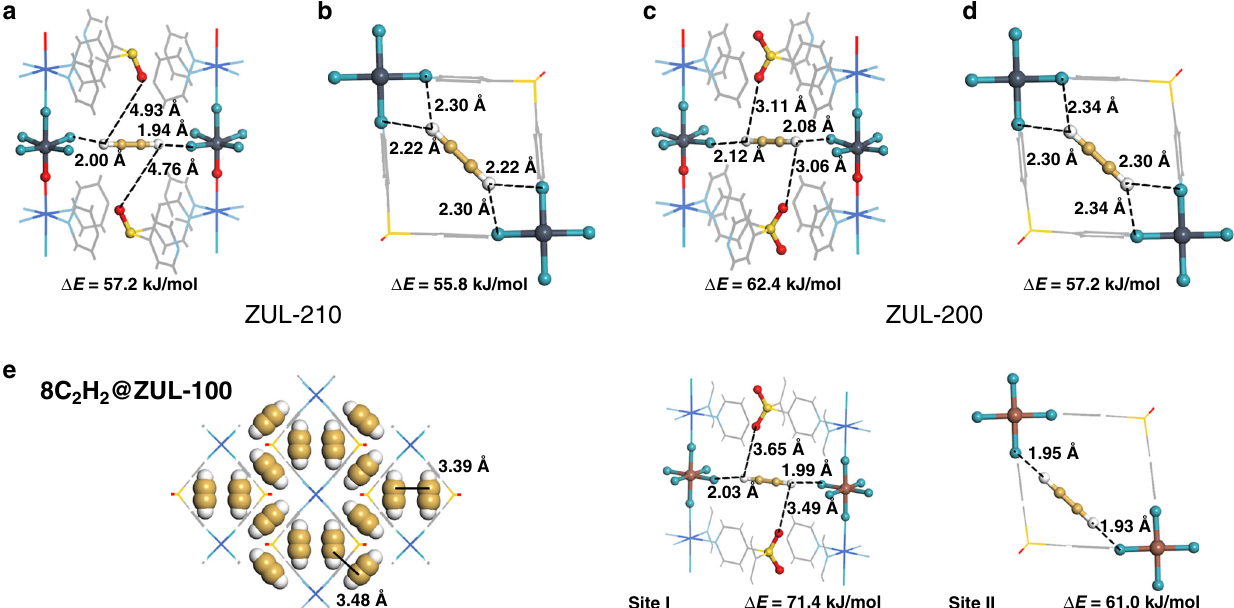
Fig. 3 DFT-D calculated C 2 H 2 binding modes. a , b The DFT-D calculated C 2 H 2 binding mode in ZUL-210. c , d The DFT-D calculated C 2 H 2 binding mode in ZUL-200. e View of the binding modes for adsorbed C 2 H 2 molecules in ZUL-100 (eight C 2 H 2 per unit cell) (Color code: F, teal; Nb, plain blue; Ti, brown; C (in framework), gray; H, white; N, sky blue; S, yellow; O, red; Cu, blue; C (in C 2 H 2 ), golden).